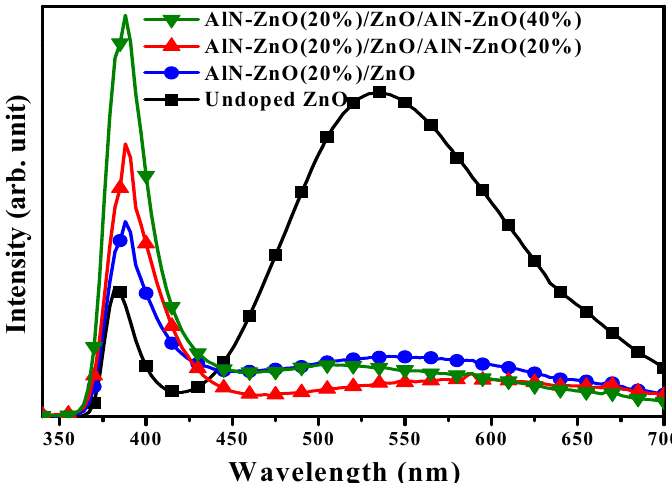
Figure 7. Room temperature photoluminescence (PL) spectra of the undoped ZnO film deposited onto the substrate with and without an AlN-ZnO buffer layer, as well as the AlN-ZnO/ZnO heterojunction structure coated by a cosputtered AlN-ZnO film at the Al atomic ratios of 20% and 40%, respectively, after annealing at 700 °C under vacuum ambient for 30 min.